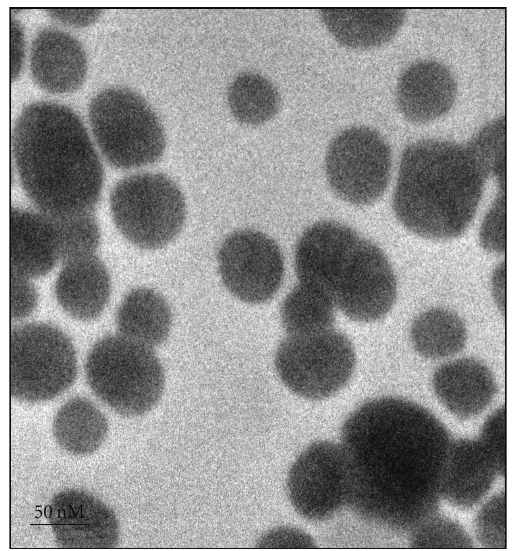
Figure 7: TEM images of the selenium nanoparticles, formed by the reaction of 1 . 0 × 10 − 3 moldm − 3 sodium selenosulphate with 2 . 0 × 10 − 2 mol dm − 3 acetic acid, in the presence of 0.01%